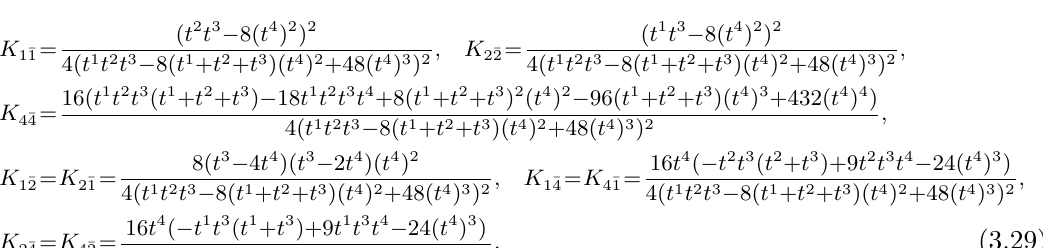
, (ii) κ , (iii) κ , where the Higgs field is identified with 1 ab 2 ab 4 ab